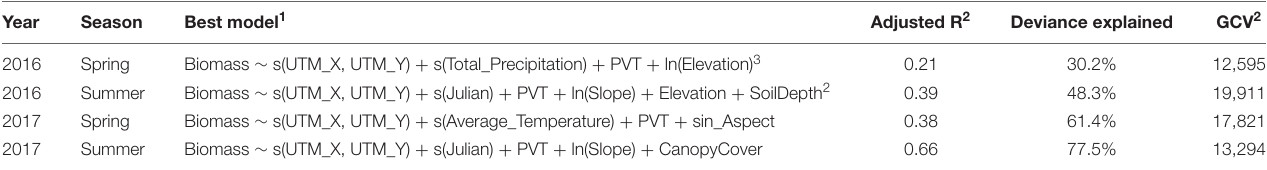
TABLE 1 | Generalized additive models (GAMs) used to predict spatiotemporal variation in the nutritional landscape (i.e., biomass of selected and neutral forage plants) available to mule deer at the Starkey Experimental Forest and Range, Oregon, United States.